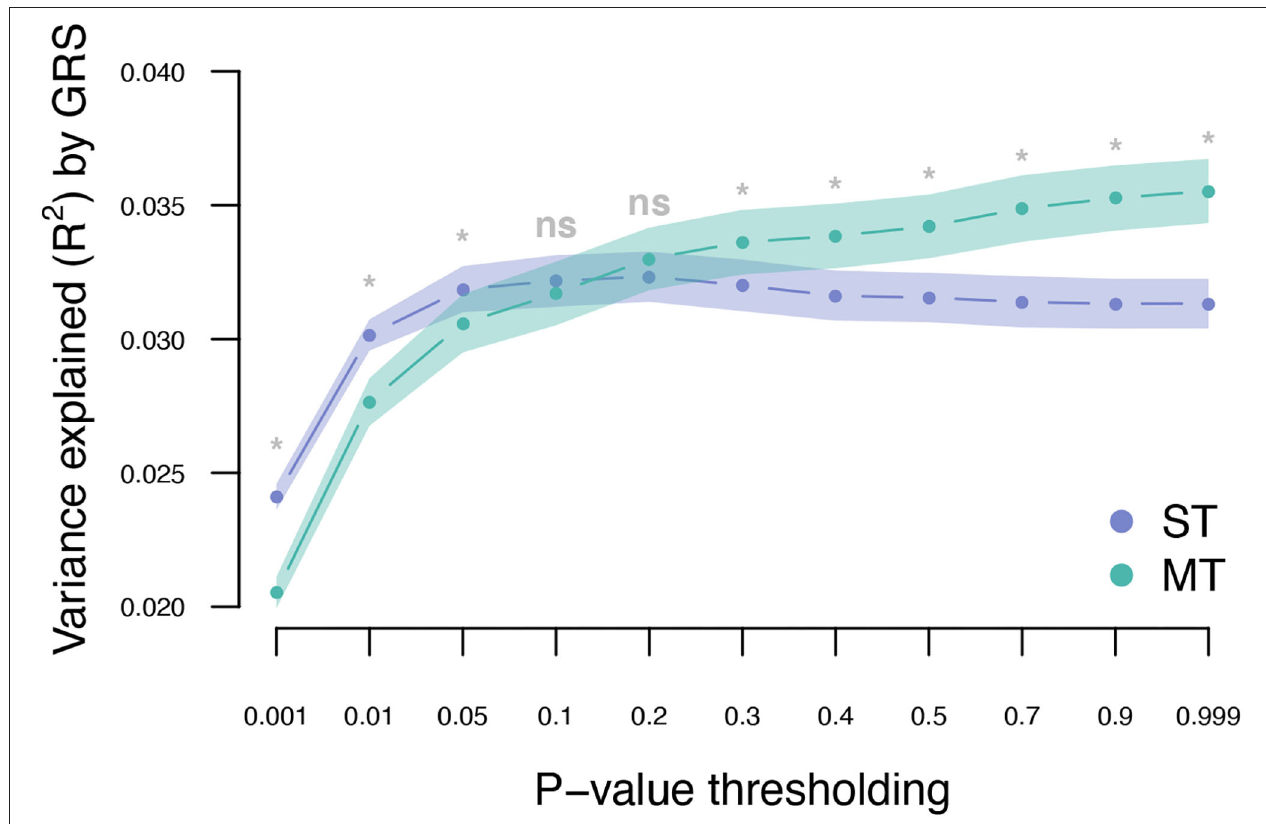
FIGURE 2 | Variance explained ( R 2 ) for type 2 diabetes by ST-GRS and MT-GRS (LD pruning r 2 < 0.9) using P -value thresholding (X-axis). Points indicate mean R 2 for a given threshold, and the surrounding shading indicates the standard error of the mean. ns, non-significant difference between ST and MT, *significant difference between ST and MT.